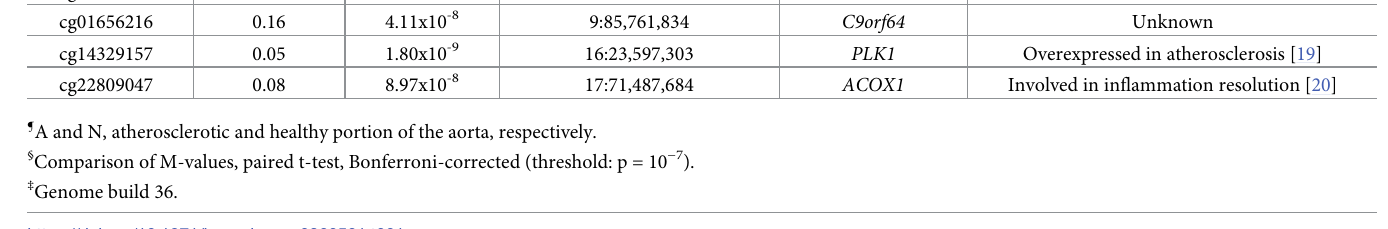
Table 1. Horvath epigenetic clock CpG (n = 353) that are significantly different between atherosclerotic and healthy portions of the aorta.